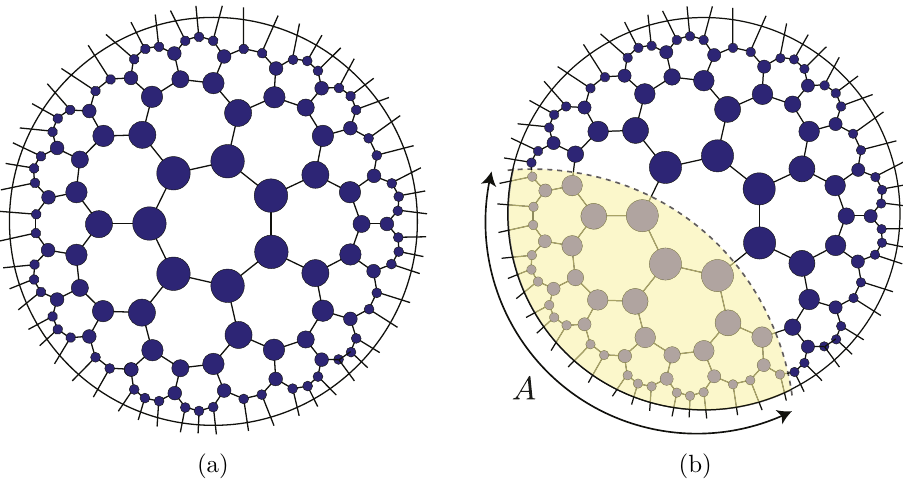
Figure 4 . (a) We tile the hyperbolic disk isometrically by a graph. Each blue circle represents a random tensor and the connecting edges indicates contraction of the tensors. This tensor network defines a state on the Hilbert space spanned by the dangling legs on the boundary. (b) The Ising domain wall that arises in the calculation of Rényi entropies of region A in the RTN. Minimizing the length of the domain wall gives rise to an entropy formula that corresponds to the RT formula in